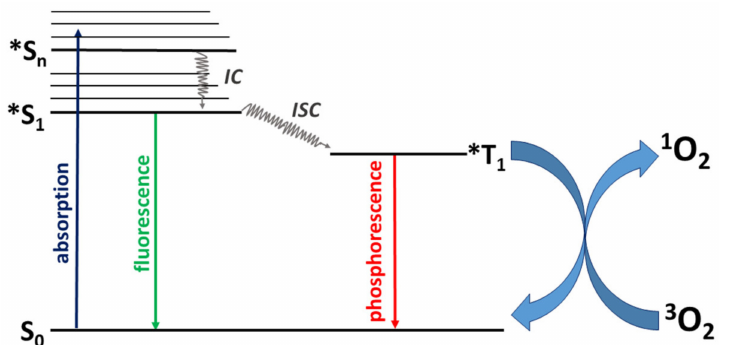
Figure 1. Jablonski diagram of the photosensitization process. S 0 –singlet ground state of photosen- sitizer, *S 1,n –singlet excited states of photosensitizers, *T 1 –triplet excited state of photosensitizer, IC –internal conversion, and ISC –intersystem